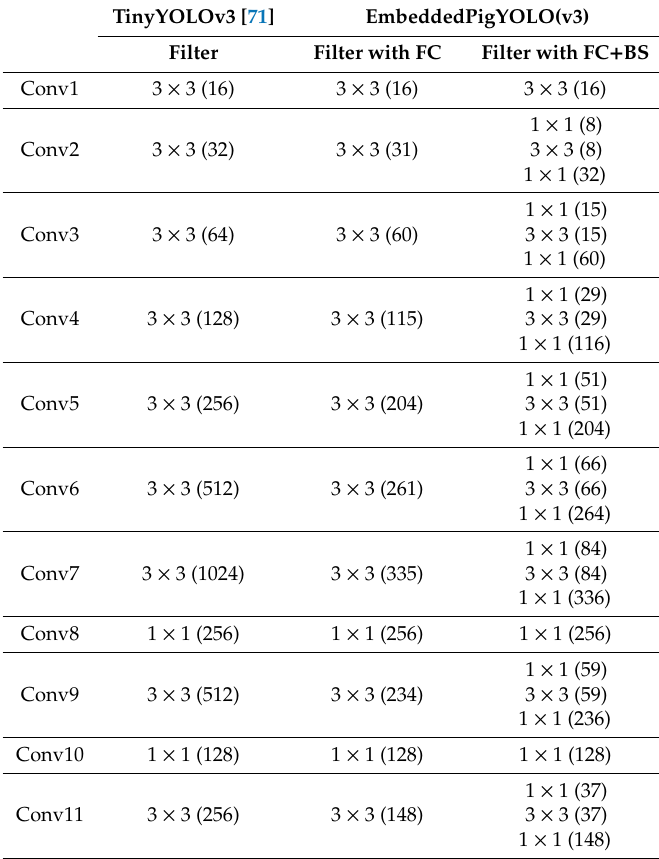
Table 3. Comparison between TinyYOLOv3 [75] and EmbeddedPigYOLO(v3) with pig data